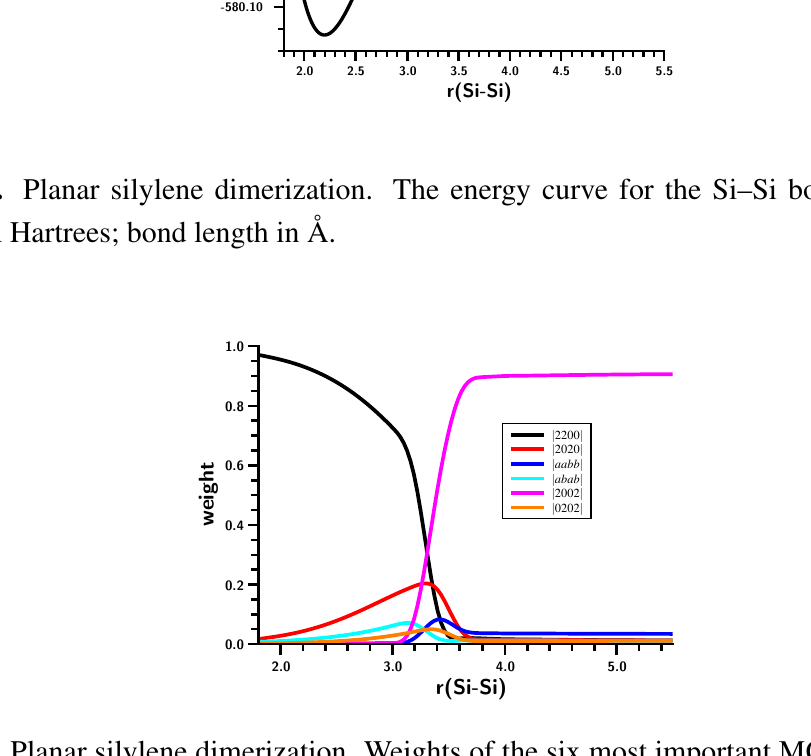
Figure 7. Planar silylene dimerization. Weights of the six most important MO-CSFs. Bond length in